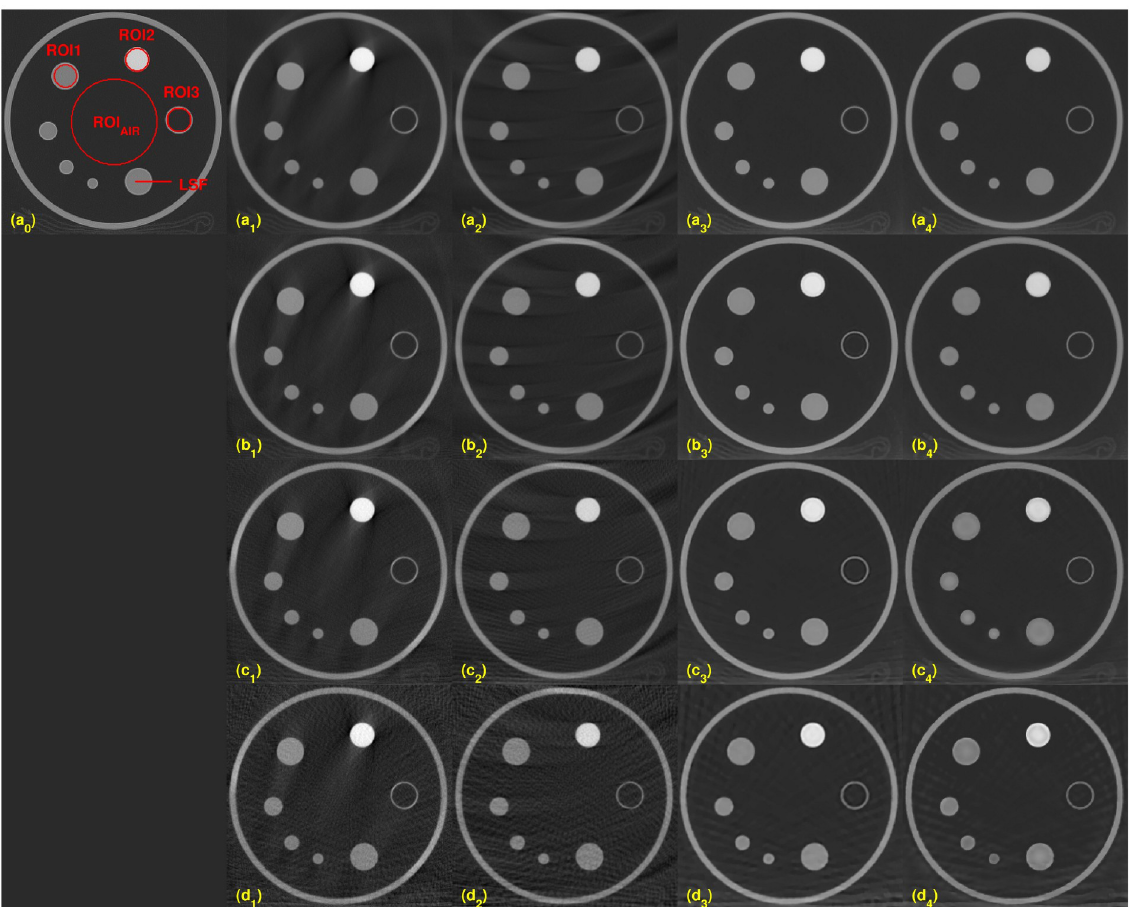
Fig 6. Reconstucted images with various sampling step sizes. From top to bottom, the sampling step size is set to 1, 4, 8, and 16. Each column consists of a different reconstruction algorithm, from left to right, scanner: FDK, Katsevich, TV and the TF algorithm. The image on (a 0 ) shows the three ROIs, and the red line is set for the computation of LSF for MTF. ROI AIR , ROI of air, is defined to compute the CNR for